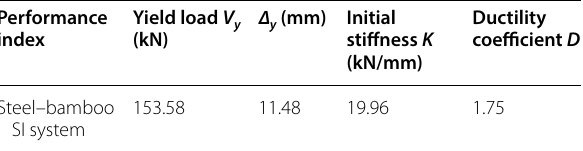
Table 3 Mechanical properties of the steel–bamboo SI system